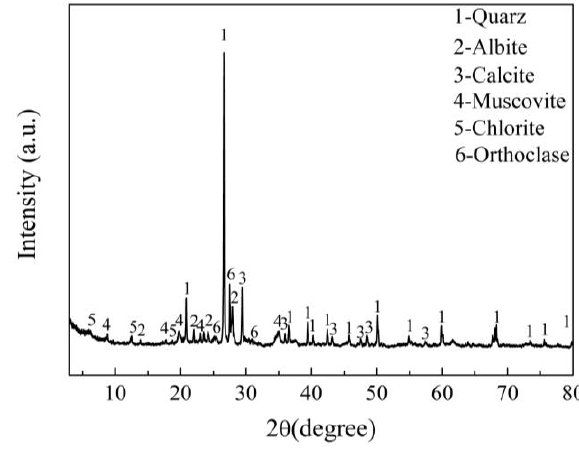
Figure 2. X-ray diffraction pattern of the earth materials. Table 2. Basic physical properties of earth materials. Table 1. Main components of soil.